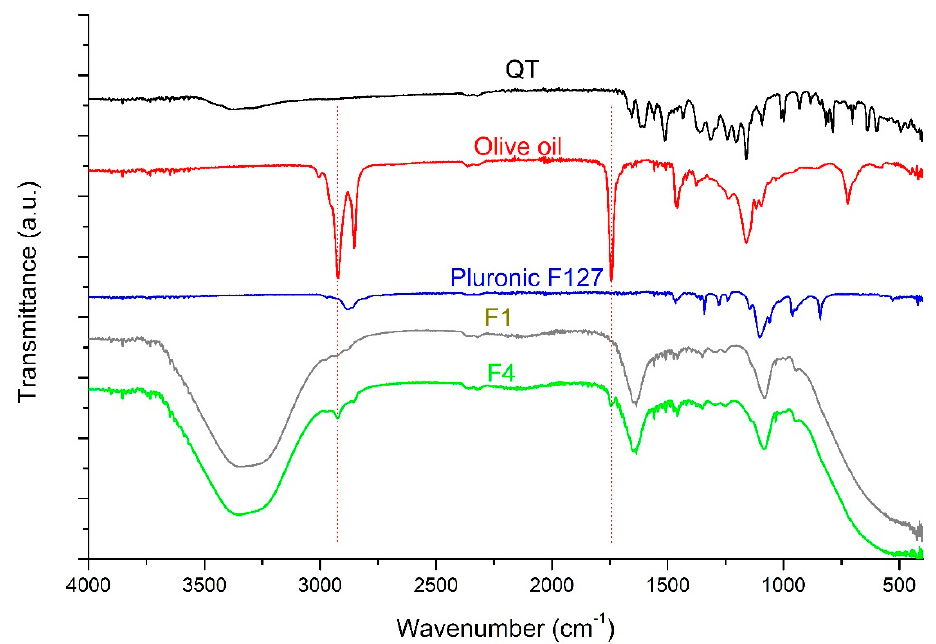
Figure 3. FT-IR spectra of QT, olive oil, Pluronic F127, F1 and F4.